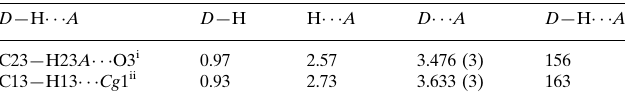
Hydrogen-bond geometry (A˚ , (cid:1)